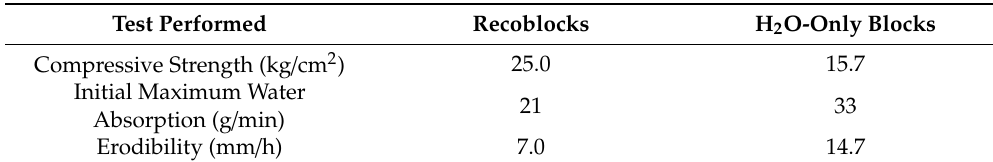
Table 12. Results of block evaluation.